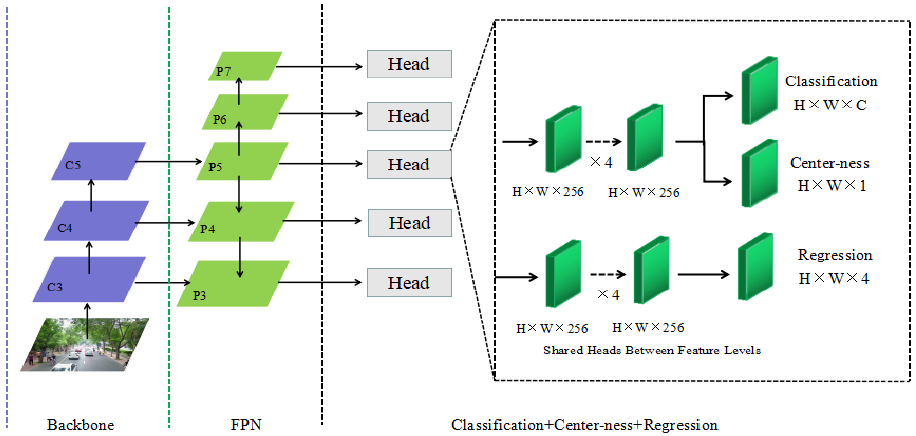
Figure 1. FCOS network